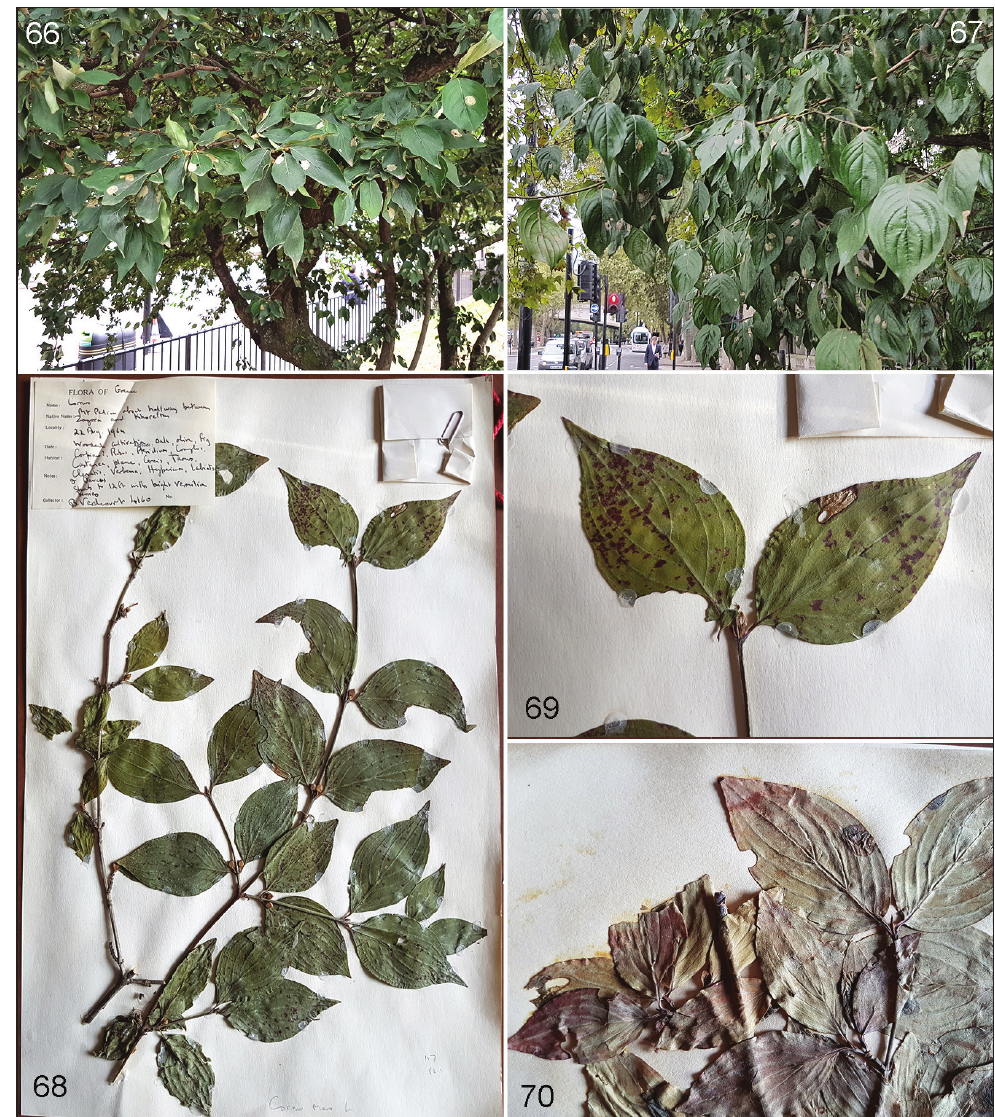
Figures 66–70. Antispila treitschkiella , invasion in the UK and herbarium specimens. 66 Leafmines of on Cornus mas at London, Hyde Park Corner, 22.ix.2016. 67 Leafmines on C. mas at London, Temple, Victoria Embank - ment, 28.ix.2016. 68 Herbarium specimen, RBG Kew, Verdcourt 4160, 22.viii.1964, from Mt. Pelion, Greece: C. mas with mines of A. treitschkiella 69 Detail of 68 70 Herbarium specimen, RBG Kew, Schneider 1681, 28.viii.1907, from Rila Mt., near Samakov, Bulgaria, C. mas with mines of A. treitschkiella . Photos David Lees.